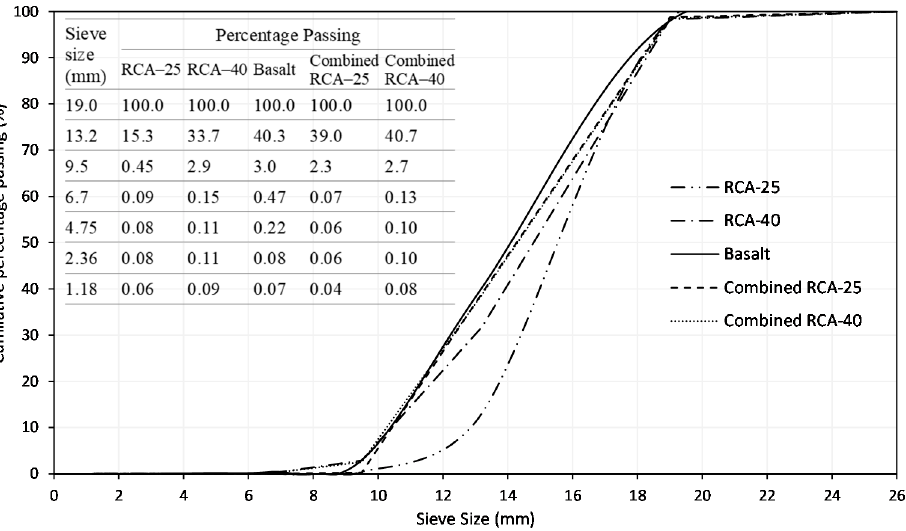
Figure 1. Aggregate grading curve for recycled coarse aggregate (RCA) and Basalt coarse aggregates. Table 4. Compressive strength of concrete with aggregate grading.